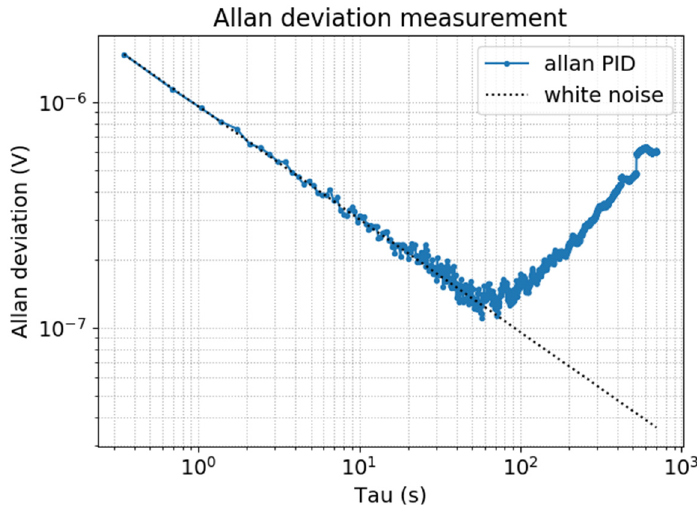
Figure 16. Allan deviation of the PA sensor in presence of a 5 ppm of NO in N 2 (blue curve) and theoretical white noise curve in 1/√𝑡 (dotted black).